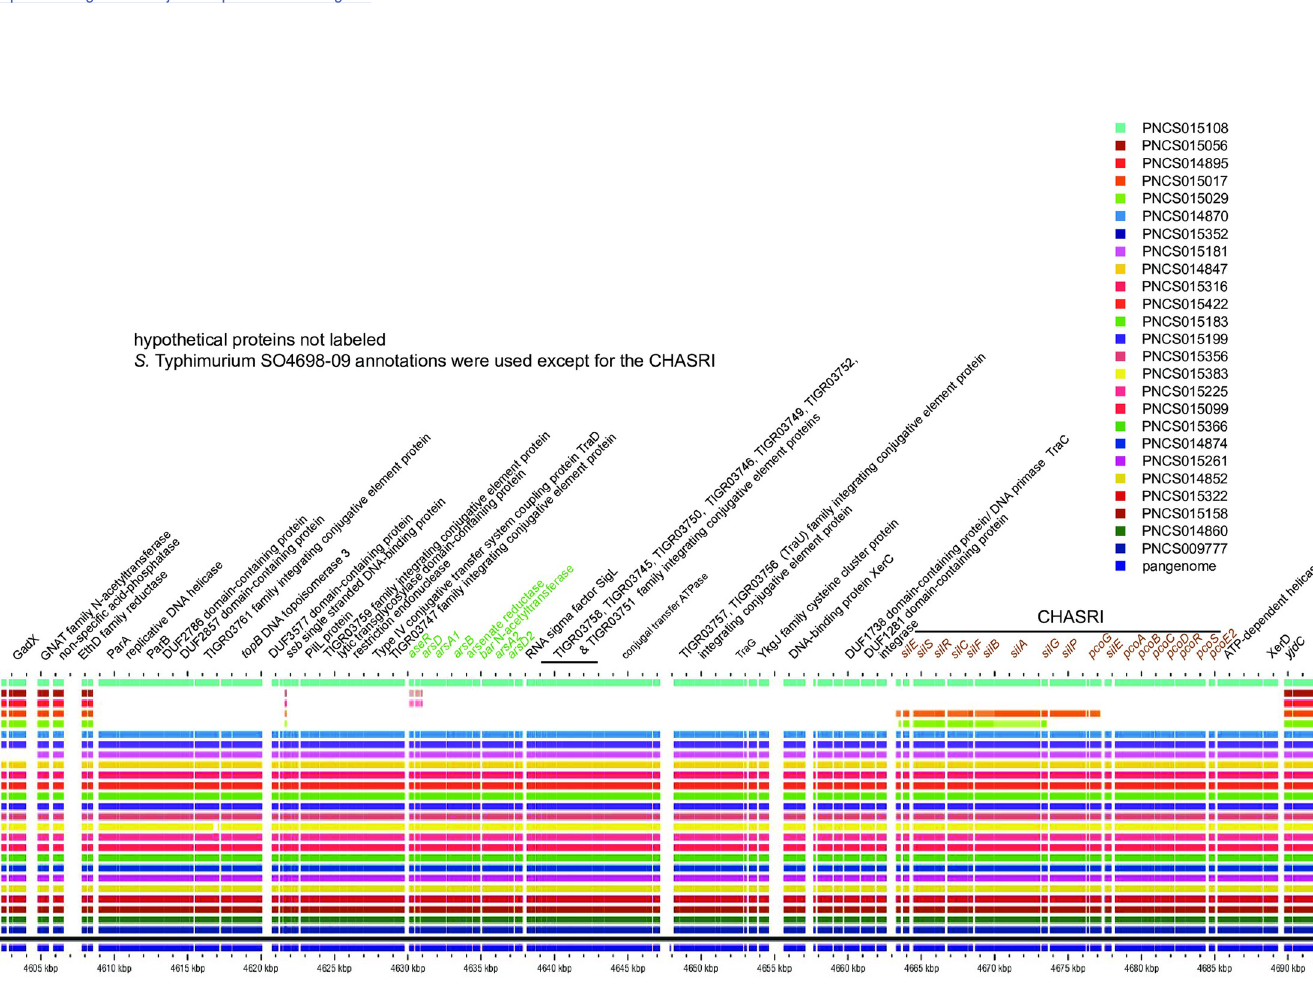
Fig 12. Heterogeneity of SGI-4 in selected, representative isolates. The figure was prepared as for Fig 11.